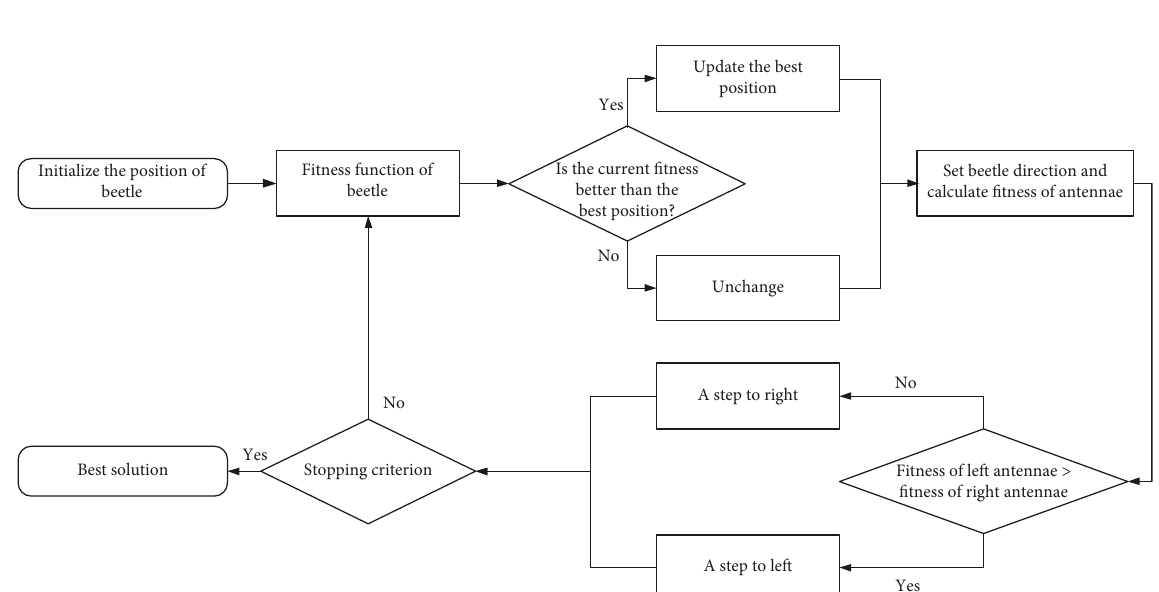
Figure 2: The flowchart of beetle antennae search